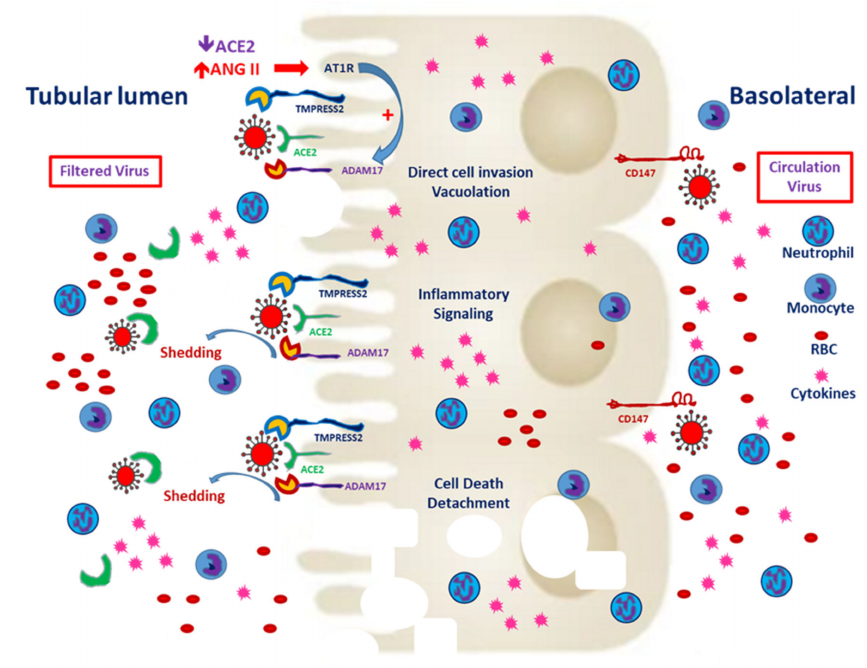
Figure 2. Severe acute respiratory syndrome coronavirus 2 (SARS-CoV-2) entry from the